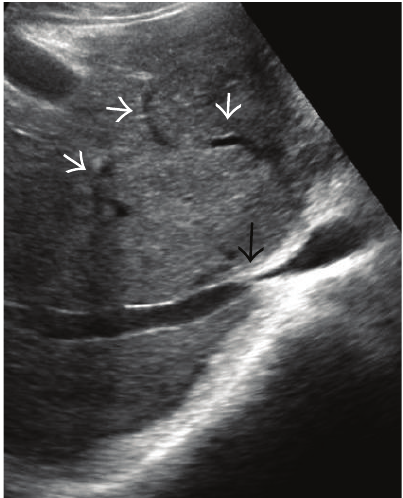
Figure 11: Gray-scale US image demonstrating stenosis at the ostium of right hepatic vein (black arrow) with multiple intrahepatic collaterals (white arrows) and heterogeneous hepatic